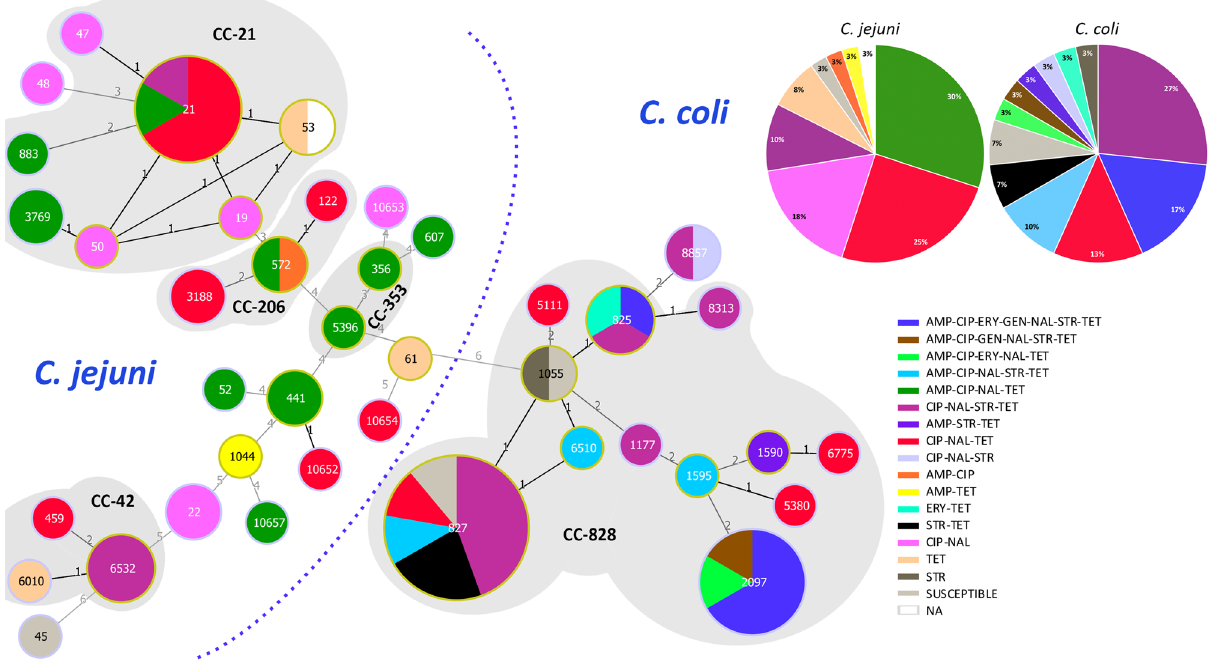
Figure 3. Minimum spanning tree of C. jejuni and C. coli isolates constructed from MLST profiles showing the distribution of the different phenotypic resistance profiles. Each node represents an ST type and the size of the node correlates to the number of isolates. Clonal complexes (CC) represented by more than one ST type are highlighted in grey shadow and the corresponding CC is indicated. Phenotypic antimicrobial resistance profiles shown as percentages are given for C. jejuni and C. coli in separate pie